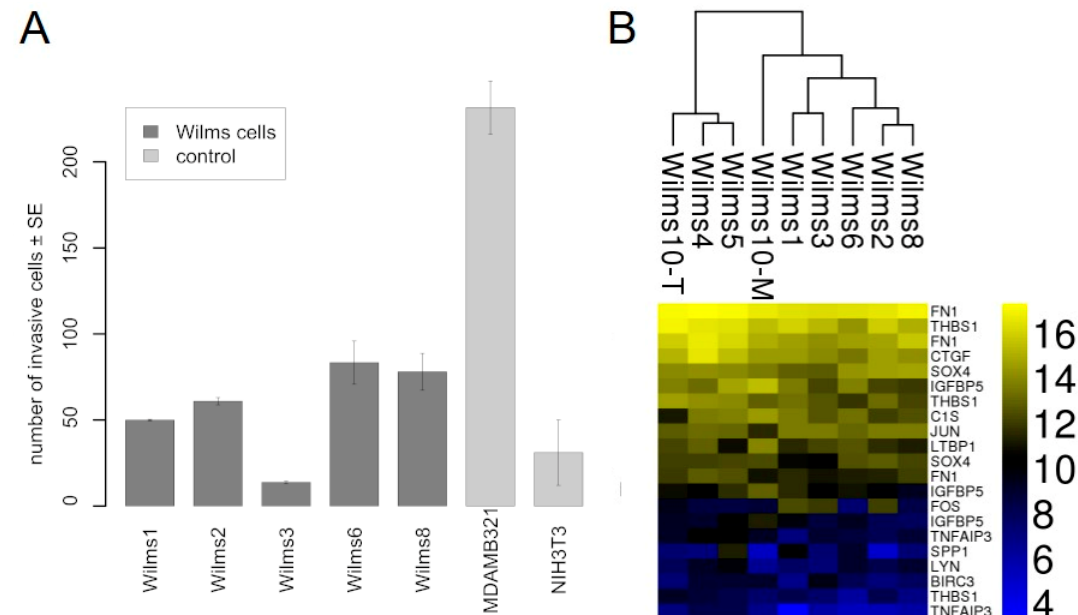
Figure 5. Invasion properties of Wilms cell lines. ( A ) The number of cells that invaded the basement membrane is shown for the tested Wilms cell lines. As controls we used nonmalignant NIH3T3 fibroblasts and MDAMB321, a highly invasive breast cancer cell line. The experiment was repeated twice and the standard error is shown. ( B ) Heat map of the CIG cluster expressed in all Wilms cell lines.